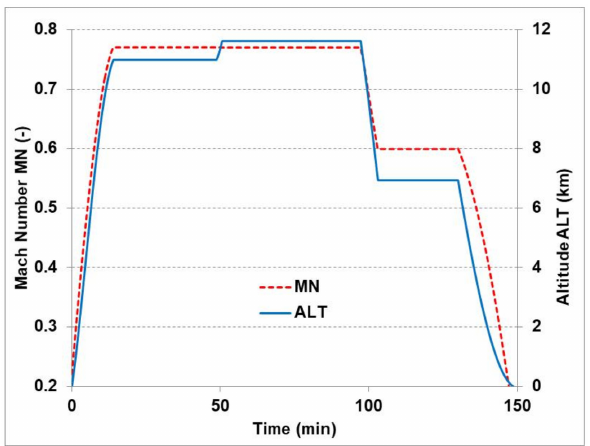
Figure 4. Variation of MN and ALT with time for the ATH–BER